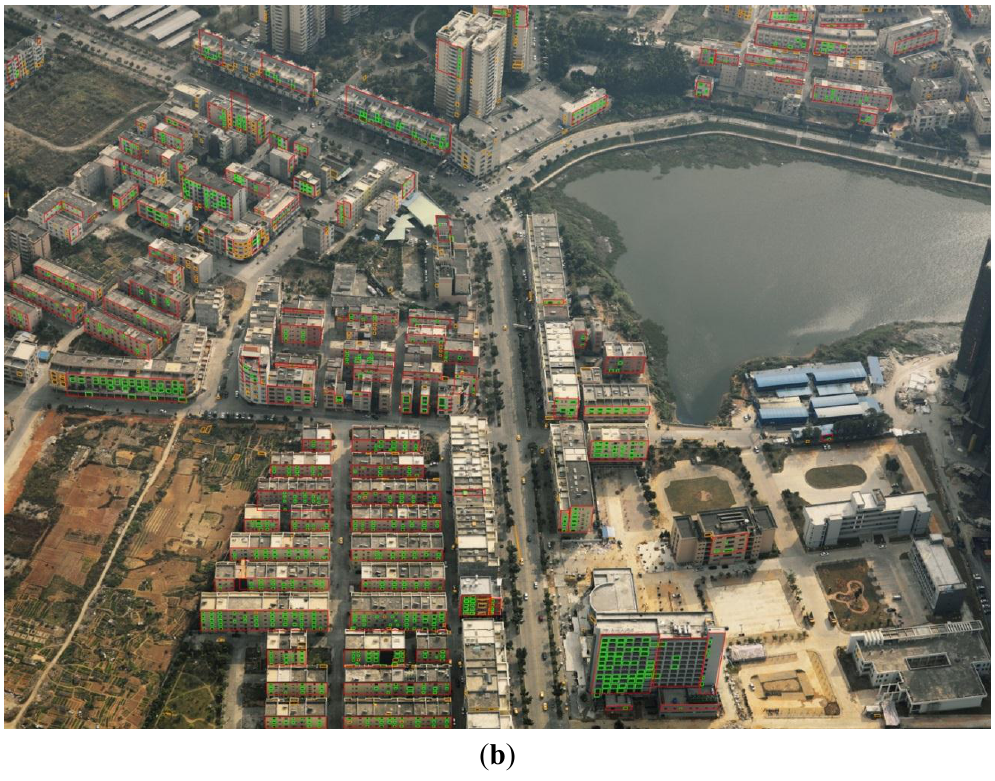
Figure 12. Results of the regional feature extraction in the image space. The green boxes show the window features, and the red boxes show the façade features. The orange quadrangles are false windows that were eliminated during the processing. ( a ) Results of reference image; ( b ) Results of search